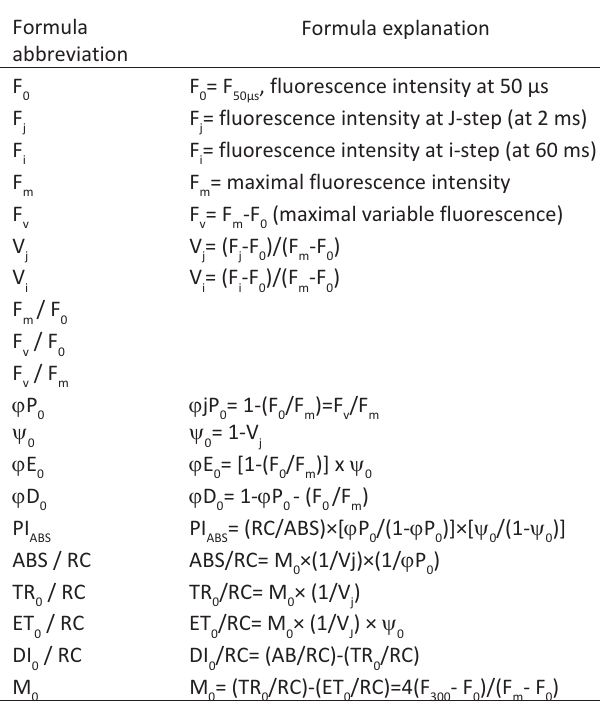
Table 2 ­ Summary of OJIP­test formula using data extracted from OJIP chlorophyll fluorescence transient.